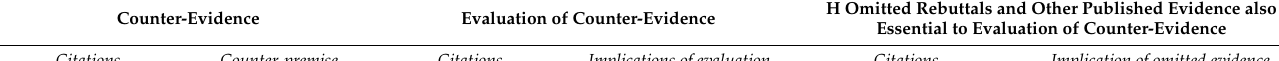
Table 3. Hagmann et al. ([3] Table 3) about historical tree density is replicated in the left two columns about counter-evidence, except that citations are changed to match our reference list. Omitted rebuttals and other omitted published evidence omitted by H are added in the right column to show Hagmann et al. omitted published evidence and made incorrect conclusions as a